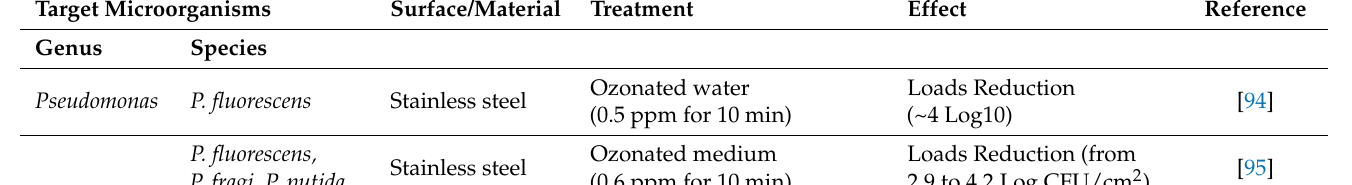
Table 2. Data on the effect of ozone on biofilms formed by dairy-related spoilage and pathogenic bacteria. Target Microorganisms Surface/Material Treatment